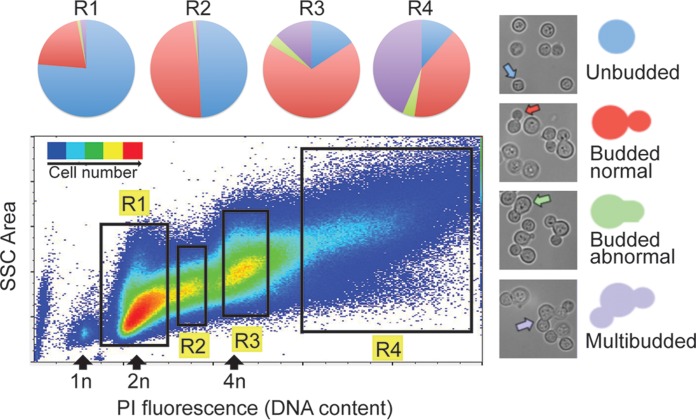
FLC treatment leads to a defect in cell separation. Cells were treated with 32 µg/ml FLC for 10 h and fixed, and the DNA was stained with PI. Subsequently, cells were fractionated using a fluorescence-activated cell sorter (FACS) instrument. Fractions of cells with increasing ploidy were collected, and morphology was scored under the microscope. The fractions of cells with highest ploidy level were enriched in multimeric cells. Multimeric cells (purple) either were trimeras, with two daughter cells formed from the mother cell, or contained an additional daughter (a granddaughter) grown from one of the daughters (purple arrow). SSC, side scatter.